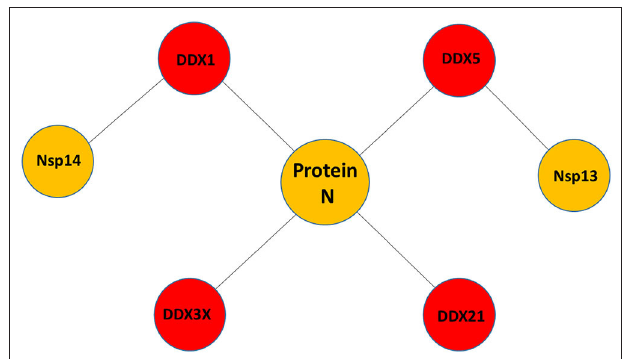
FIGURE 1 | Pattern of putative interactions between host DDX helicases and SARS-CoV-2 proteins. These interactions were experimentally observed in other coronaviruses sharing highly conserved viral proteins with